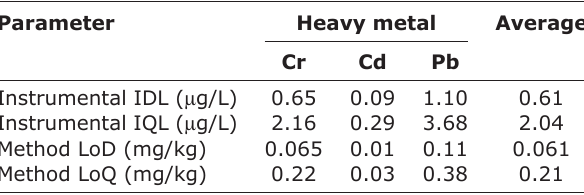
Table-4: The results of IDL, IQL, and method LoD and LoQ of the heavy metals in poultry feed.